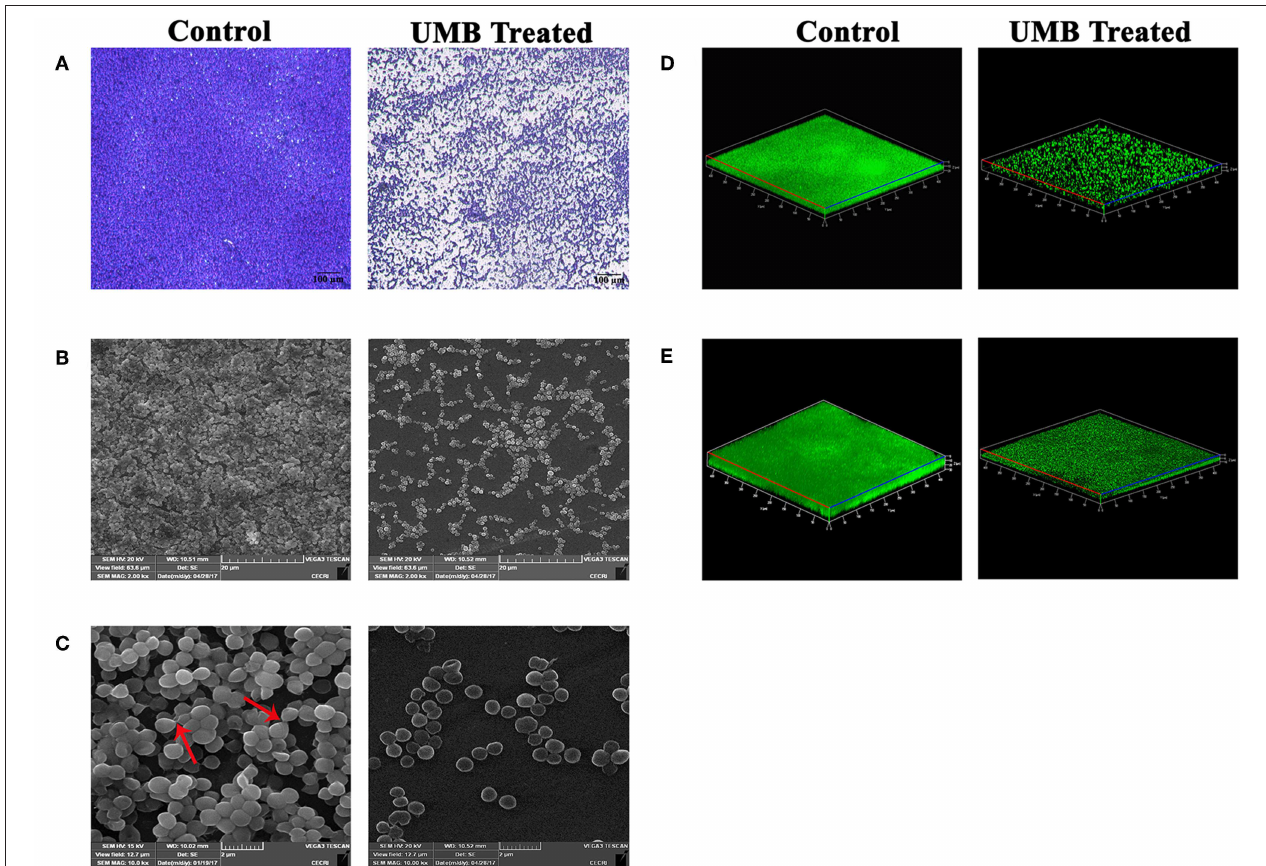
FIGURE 3 | Microscopic images of MRSE biofilm formed in the absence and presence of UMB (at 500 µ g/ml). (A) LM (400X, scale bar- − 100 µ m), (B) SEM (2000X, scale bar- − 20 µ m), and (C) SEM (10,000X, scale bar- − 2 µ m) images displaying reduced biofilm surface coverage area and less aggregated monolayer biofilm in UMB treated glass slides than that of control glass slides. Red arrows in SEM image of control slide (10,000X) denote adhesiveness between cells. Adhesiveness could not be seen in treated slide. Three dimensional CLSM images depicting significant reduction of biofilm formation on (D) glass as well as (E) titanium surfaces upon treatment with UMB (at 500 µ g/ml).